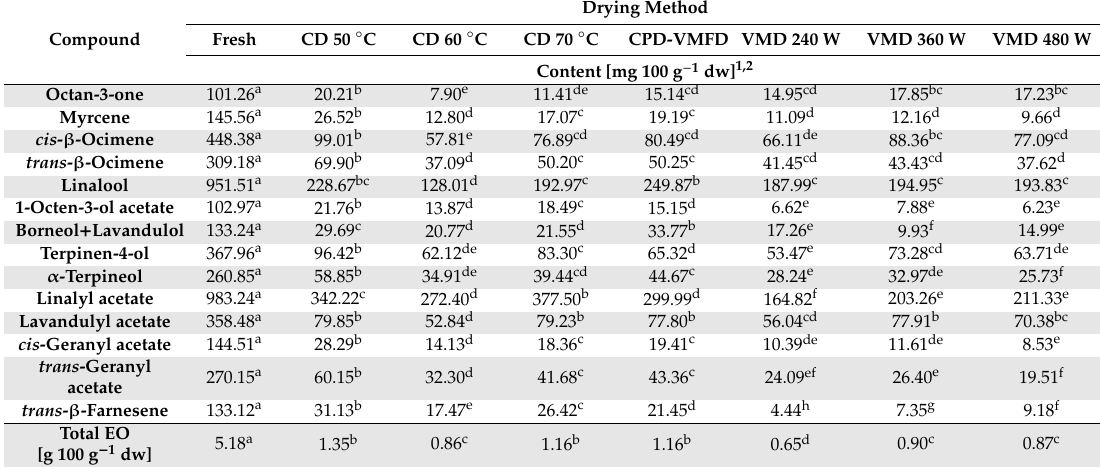
Table 3. Variability of true lavender flower essential oils (EOs) major constituents and total EO a ff ected by various drying methods.